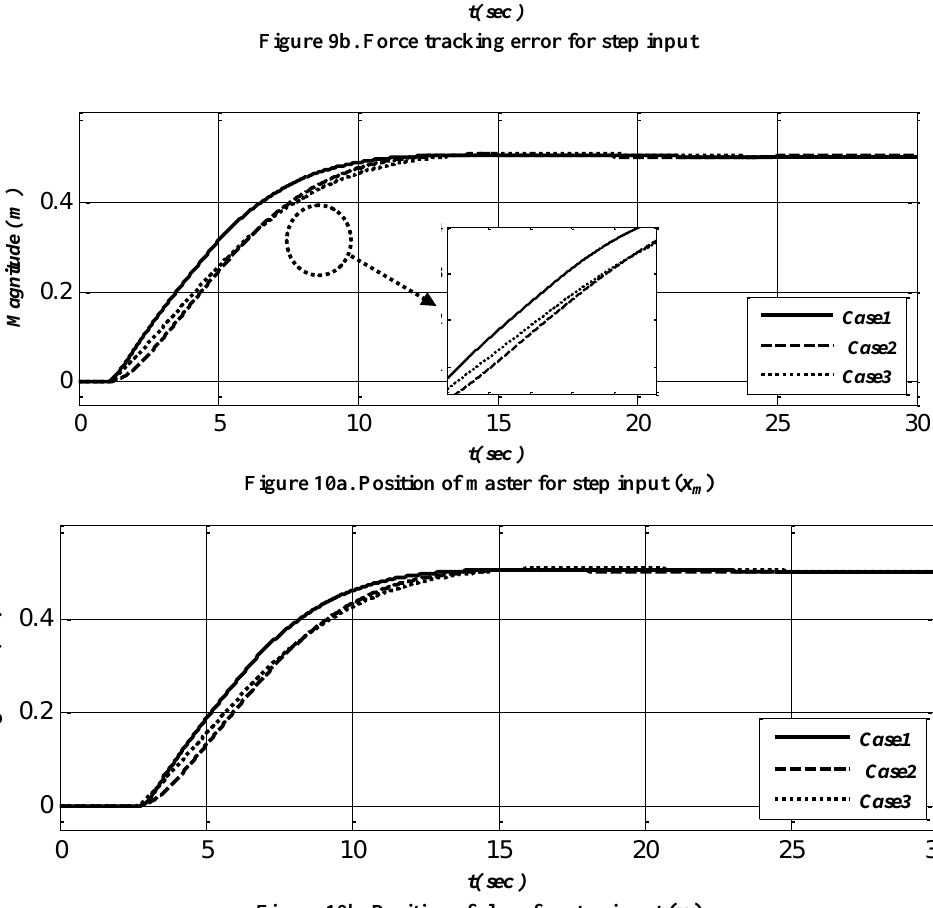
Figure 10b. Position of slave for step input ( x s